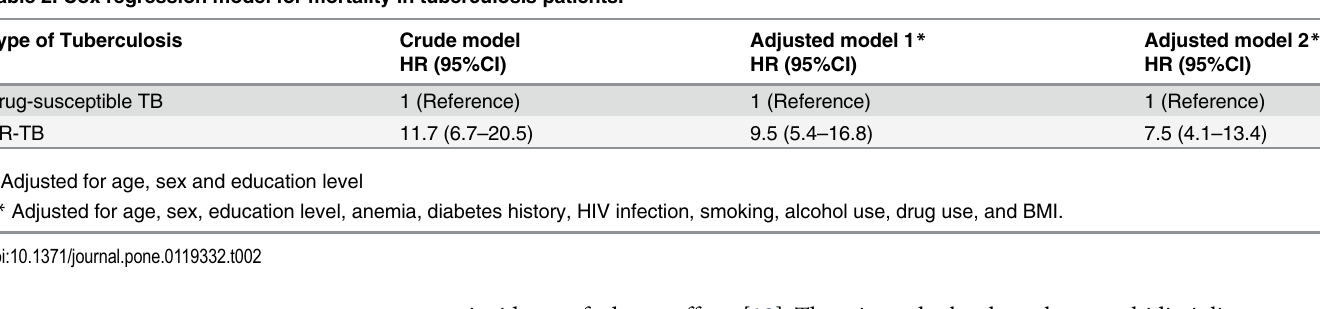
Table 2. Cox regression model for mortality in tuberculosis patients.